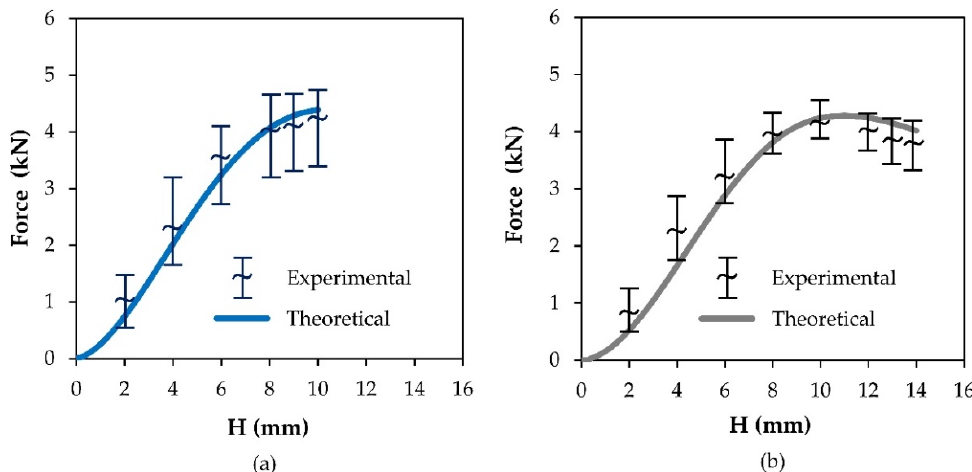
Figure 9. Evolution of the tool force with groove depth for the ( a ) additively deposited and ( b ) wrought commercial AISI 316L stainless-steel sheets.